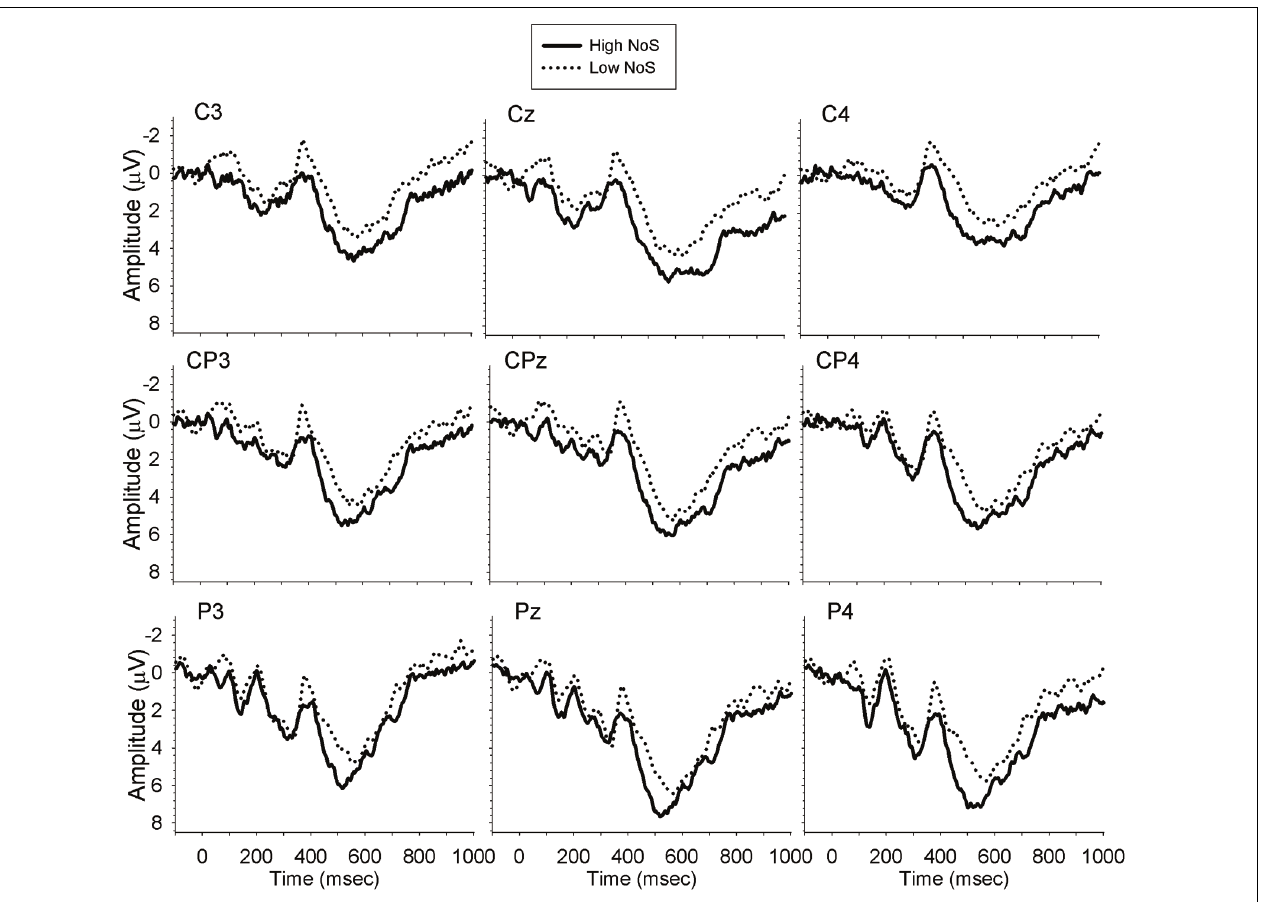
FIGURE 3 | Waveforms elicited by bilinguals performing the task in their